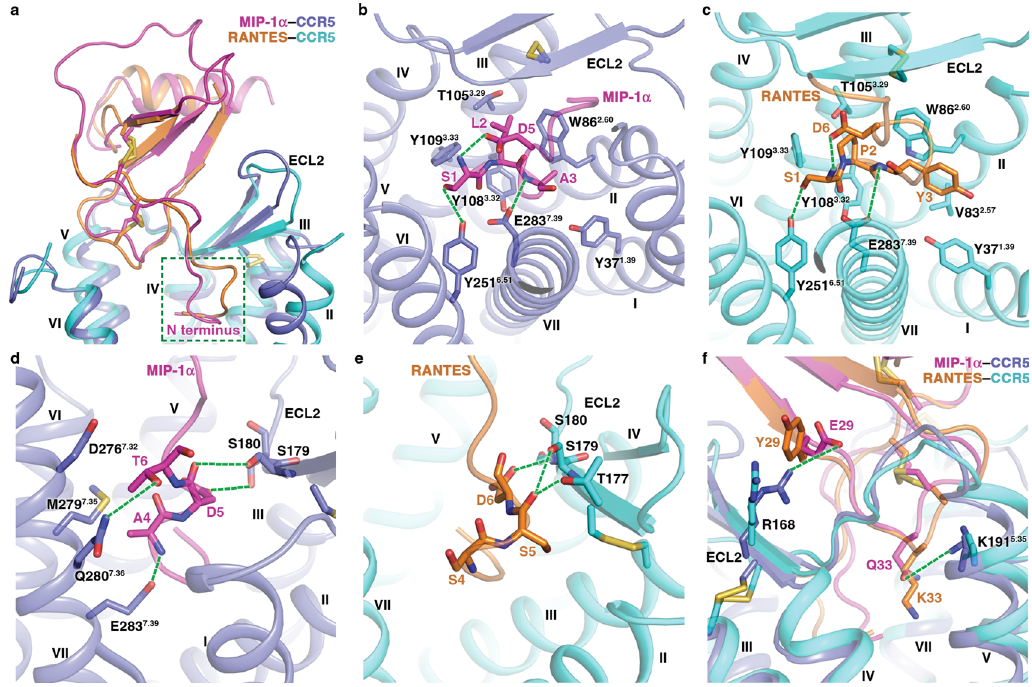
Fig. 3 Binding modes of MIP-1 α and RANTES in CRS2. a Comparison of the binding poses of MIP-1 α and RANTES in CCR5. The structures of MIP- 1 α – CCR5 – G i1 and RANTES – CCR5 – G i1 are shown in cartoon representation and colored blue (CCR5)/magenta (MIP-1 α ) and cyan (CCR5)/orange (RANTES). The N-terminal regions of the chemokines are highlighted by a green dashed box. b , d Binding mode of the N-terminal residues of MIP-1 α . b Binding mode of the MIP-1 α residues S1 – A3; d binding mode of the MIP-1 α residues A4-T6. The MIP-1 α – CCR5 – G i1 structure is shown in cartoon representation. The MIP-1 α and CCR5 residues that are involved in interactions are shown as sticks with magenta and blue carbons, respectively. The polar interactions are displayed as green dashed lines. c , e Binding mode of the N-terminal residues of RANTES. c Binding mode of the RANTES residues S1 – Y3; e binding mode of the RANTES residues S4-D6. The RANTES – CCR5 – G i1 structure is shown in cartoon representation. The RANTES and CCR5 residues that are involved in interactions are shown as sticks with orange and cyan carbons, respectively. The polar interactions are displayed as green dashed lines. f Comparison of interactions formed by the chemokine residues 29 and 33. The structures of MIP-1 α – CCR5 – G i1 and RANTES – CCR5 – G i1 are shown in cartoon representation. The MIP-1 α residues E29 and Q33 and the CCR5 residues R168 and K191 5.35 form polar interactions in the MIP-1 α – CCR5 – G i1 structure and the counterparts in the RANTES – CCR5 – G i1 structure are shown as